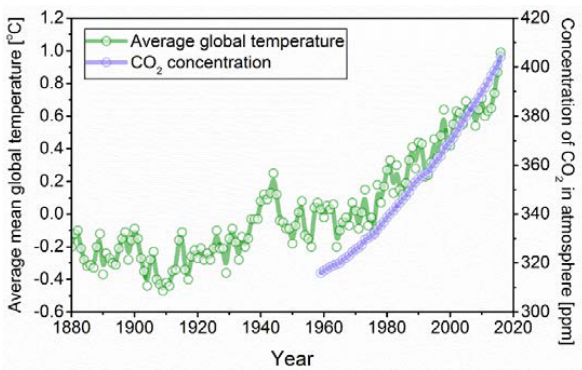
Figure 1. The rise in average global temperatures and CO 2 concentrations in the atmosphere. The graph was built based on data from NASA’s Goddard Institute for Space Studies (NASA/GISS) and from Dr. Pieter Tans, National Oceanic and Atmospheric Administration at Earth System Research Laboratory (NOAA/ESRL) (www.esrl.noaa.gov/gmd/ccgg/trends/) and Dr. Ralph Keeling, Scripps Institution of Oceanography (scrippsco2.ucsd.edu/).